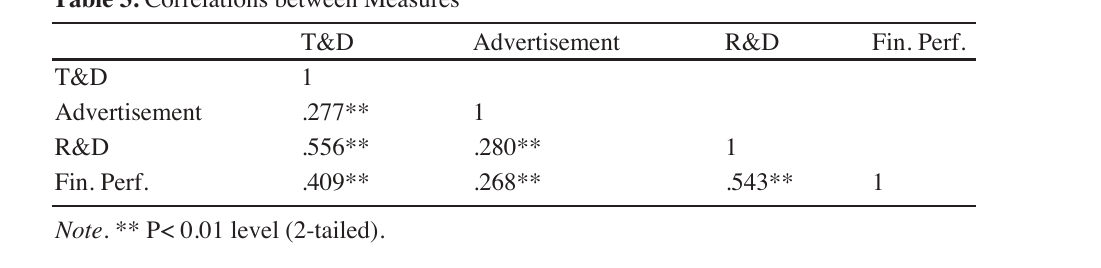
Table 3. Correlations between